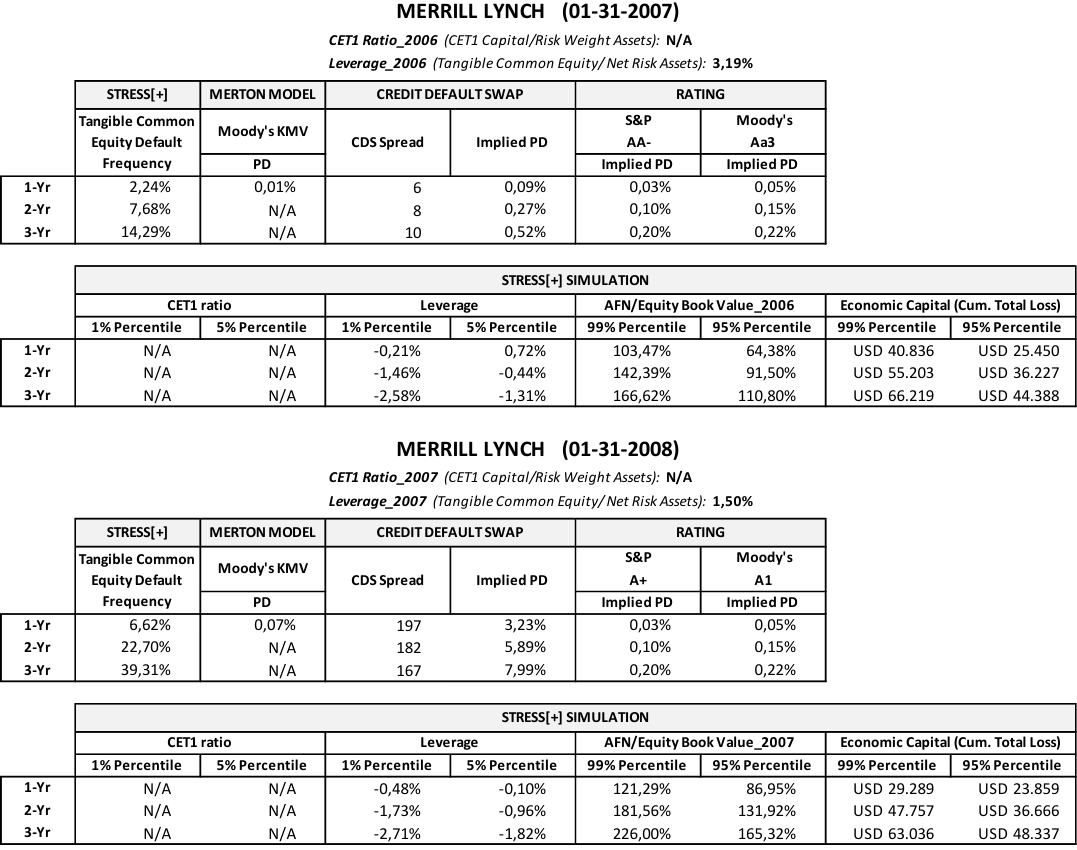
Figure A12. Backtesting comparative analysis: Merrill Lynch. (Source of CDS, KMV data, rating: Bloomberg, Moody’s KMV, Standard & Poor’s ).